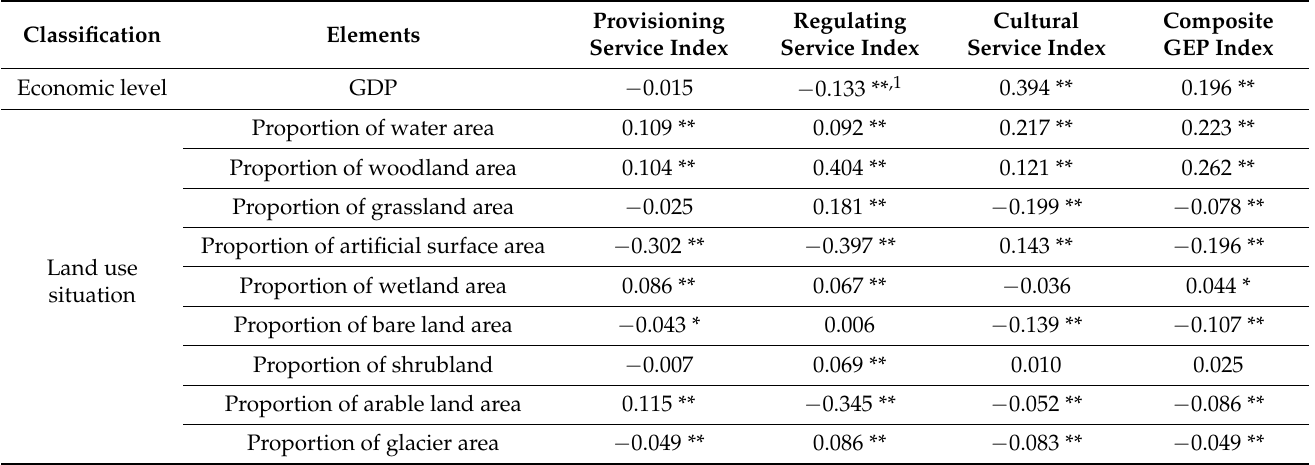
Table 2. Correlation between GEP indices and economic level and land use situation